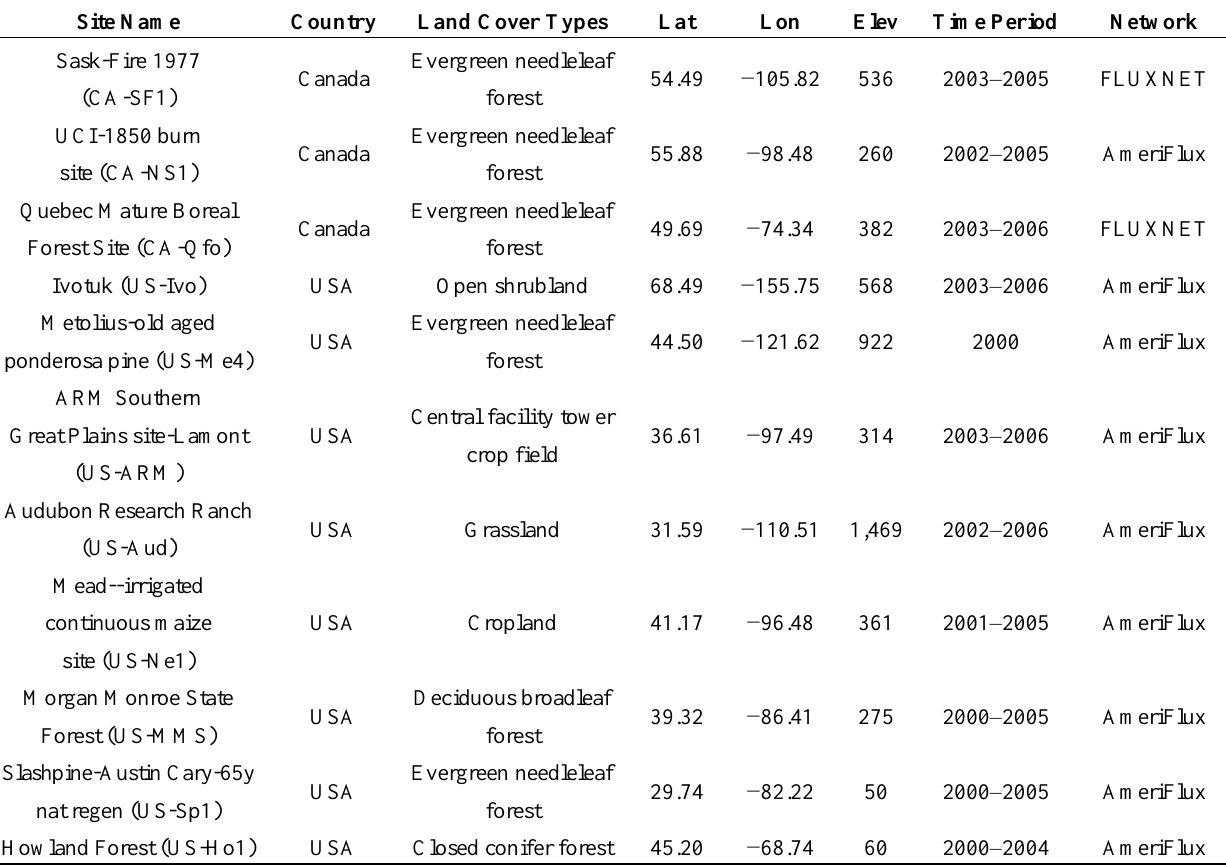
Table 1. A description of site conditions. Land cover types, Latitude (Lat), longitude (Lon), Elevation (Elev, meter), time-period, and network names are shown